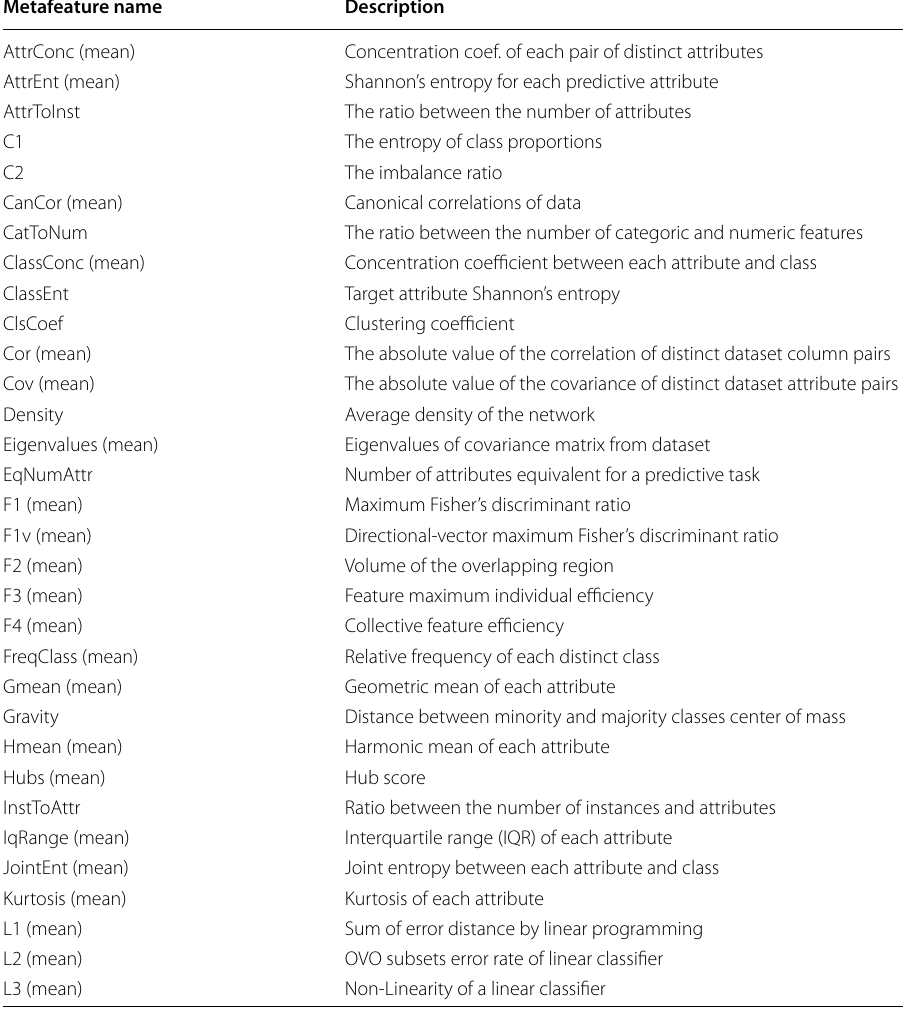
Table 4 Dataset properties used in the